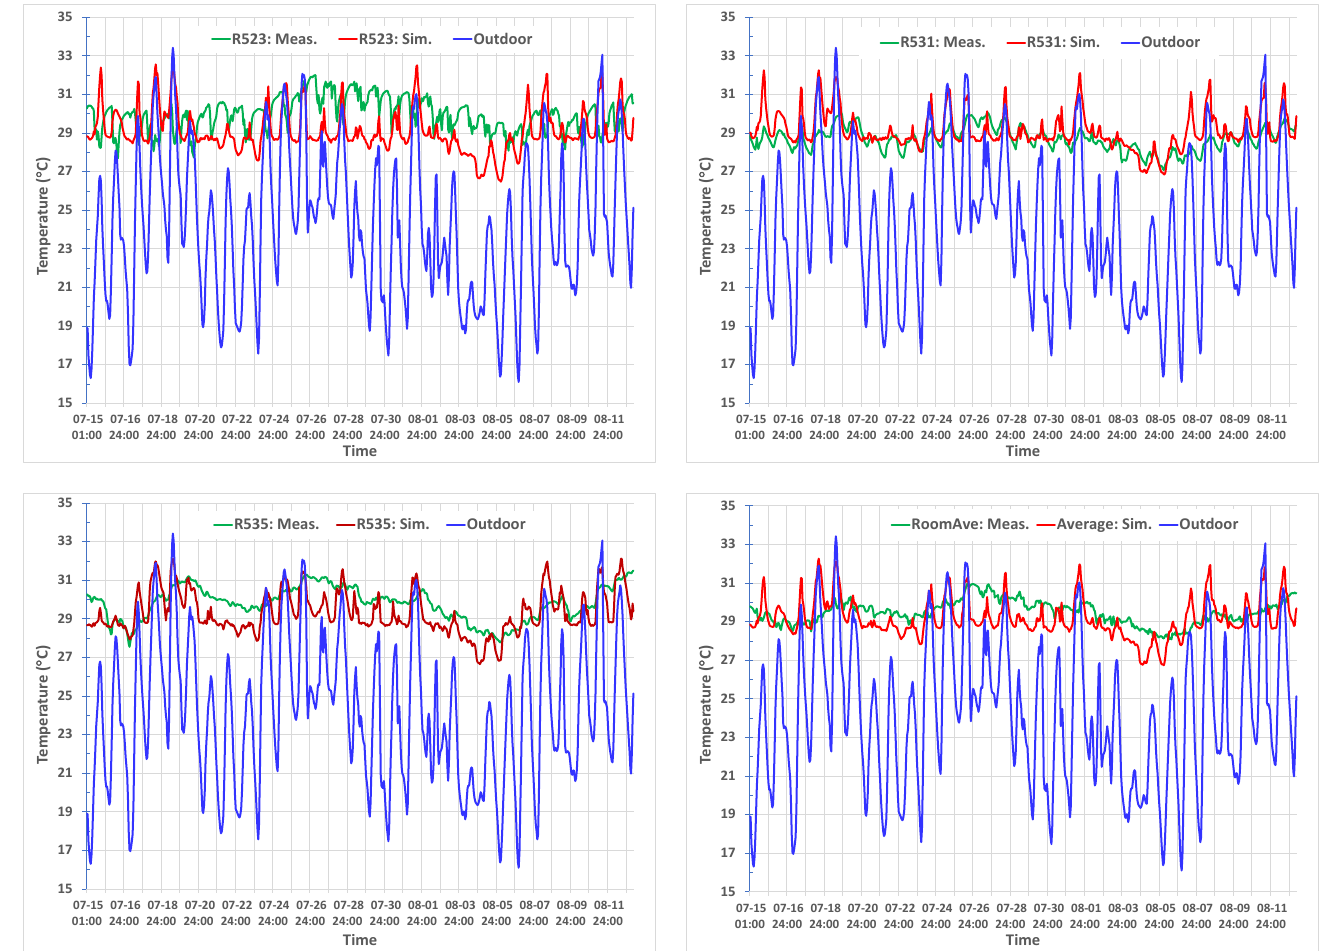
Figure 5. Comparison of indoor temperatures of bedrooms (R523, R531, and R535) and their average value.